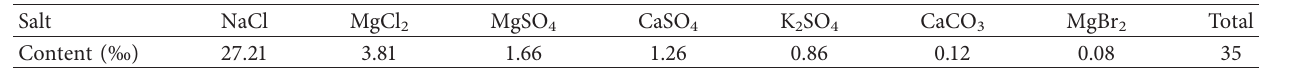
Table 4: The main salt content of the artificial seawater.